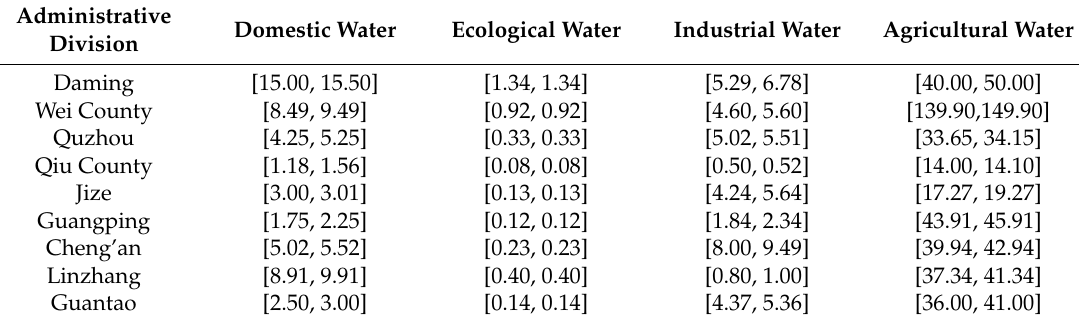
Table 4. Result of surface water allocated to every user (10 6 m 3 ).